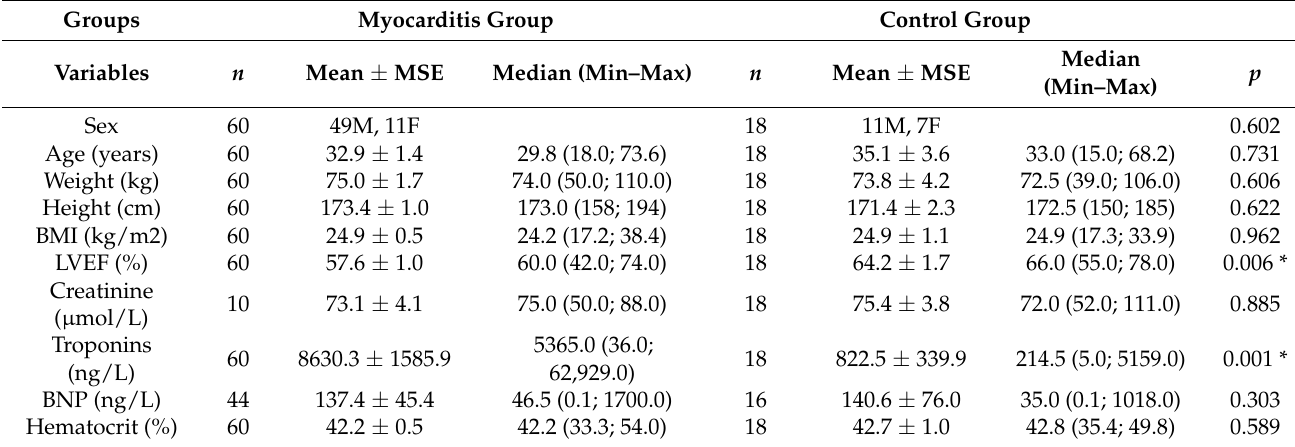
Figure 1. Flow chart of the study population. Table 1. Baseline characteristics of the study population.